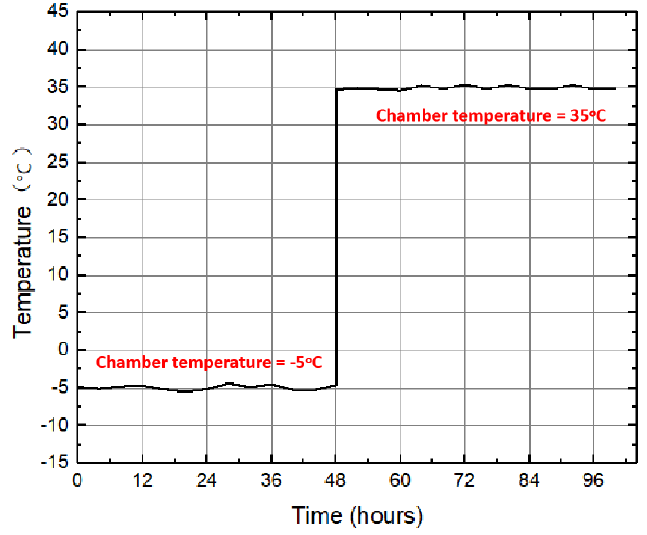
Figure 9. Results of the system’s continuous temperature measurement for more than 100 h.